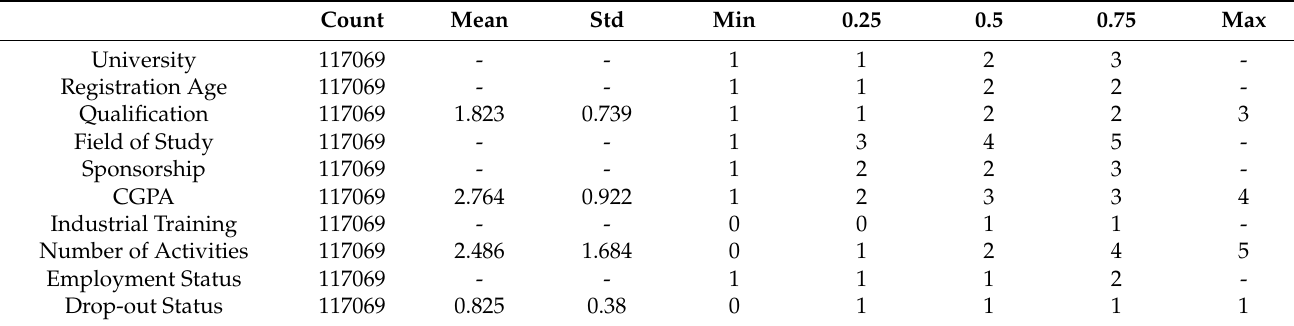
Table 3. Descriptive analysis of student’s